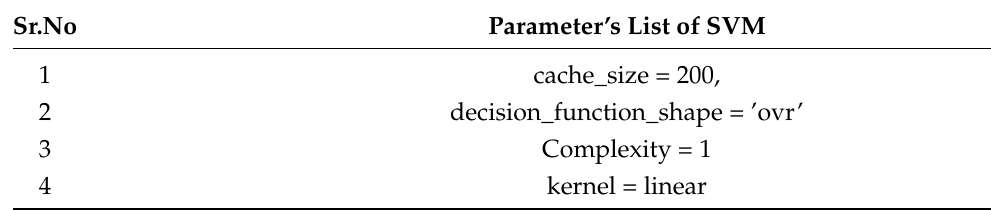
Table 1. SVM classification parameters.